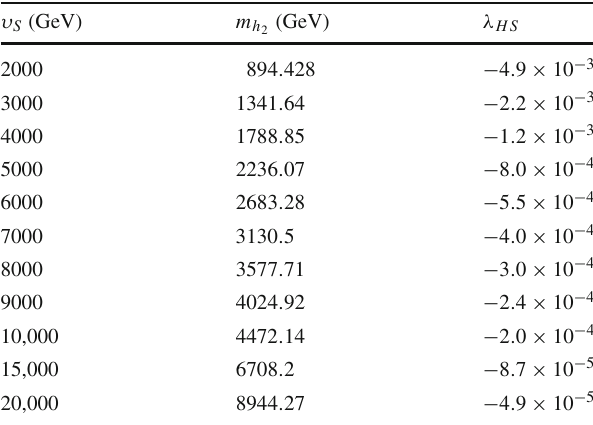
due to the see-sawic 2